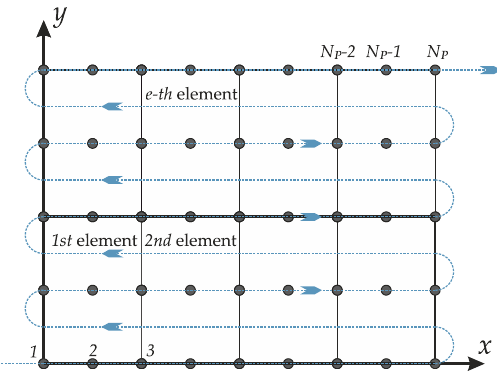
Figure 4. Discrete domain, identification of the elements and node numbering.